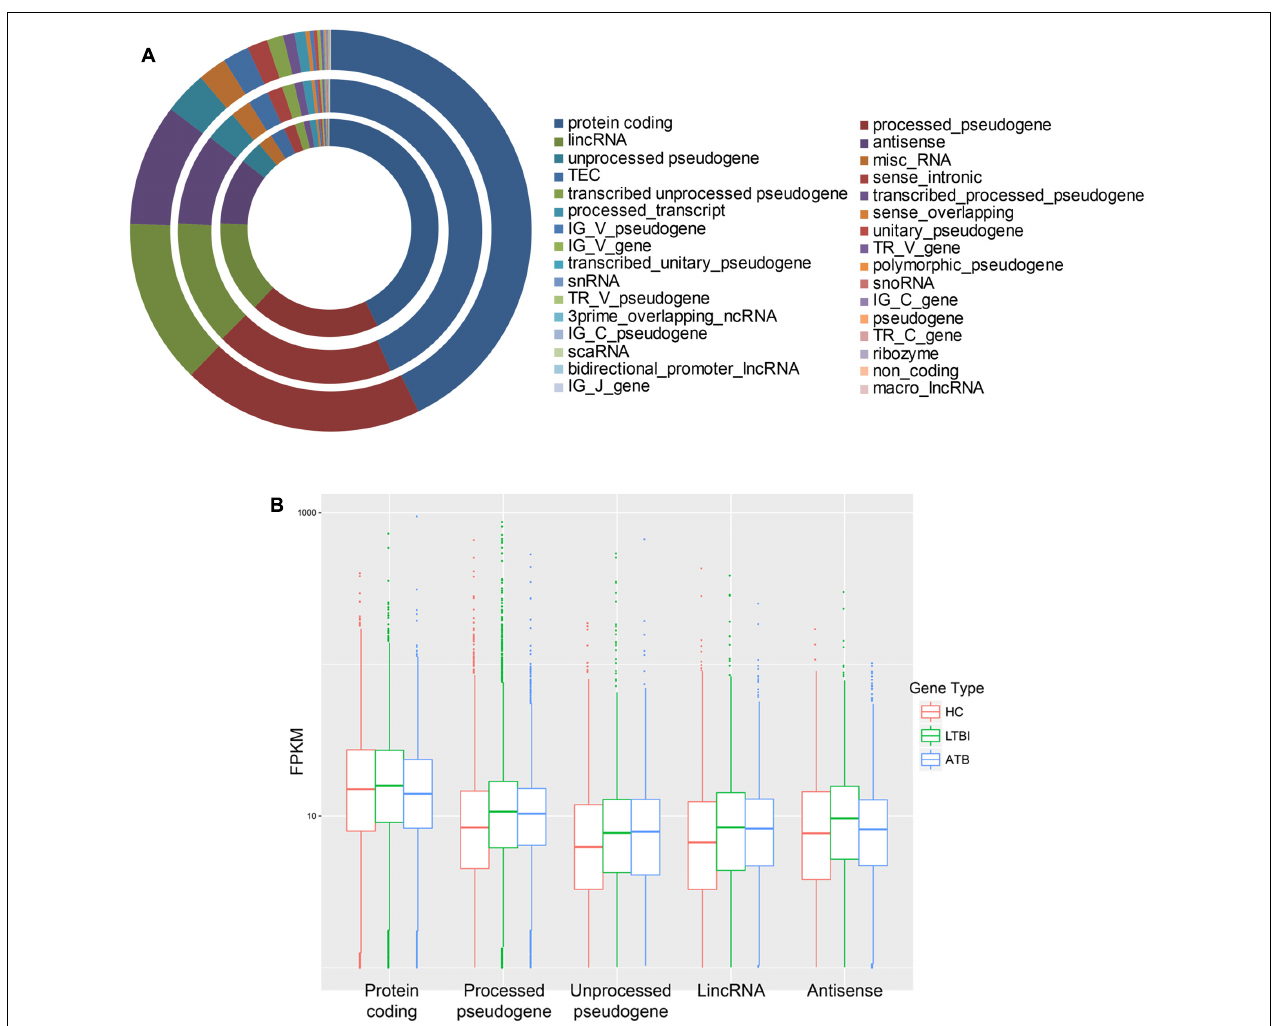
FIGURE 1 | General gene expression profiles among healthy control (HC), LTBI, and ATB samples. (A) Many types of RNAs were secreted into the exosomes (shown in different colors). They also shared a similar proportion of gene number in each sample (circles from outer to inner represent HC, LTBI, and ATB). (B) The FPKM values of top-five types of RNAs in the three